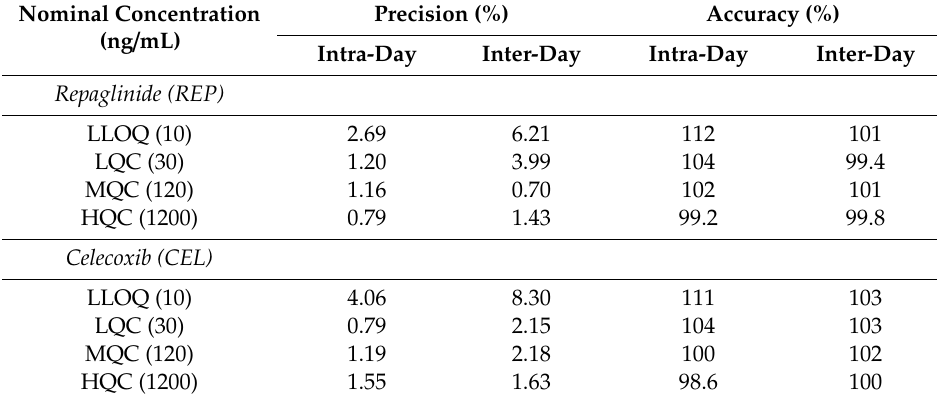
Figure 2. Representative chromatograms of repaglinide (REP), celecoxib (CEL), and ketoconazole (IS) in rat plasma: blank rat plasma ( A ); blank rat plasma spiked with REP, CEL (10 ng / mL, lower limit of quantification (LLOQ)), and IS ( B ); blank rat plasma spiked with REP, CEL (120 ng / mL, middle quality control (MQC)), and IS ( C ); plasma sample collected 120 min after concurrent oral administration of REP and CEL solution in rats, where calculated concentrations of REP and CEL were 53 and 968 ng / mL, respectively ( D ). EU: emission unit. Table 1. Intra- and inter-day precision and accuracy of REP and CEL in rat plasma ( n = 5). HQC: high quality control.